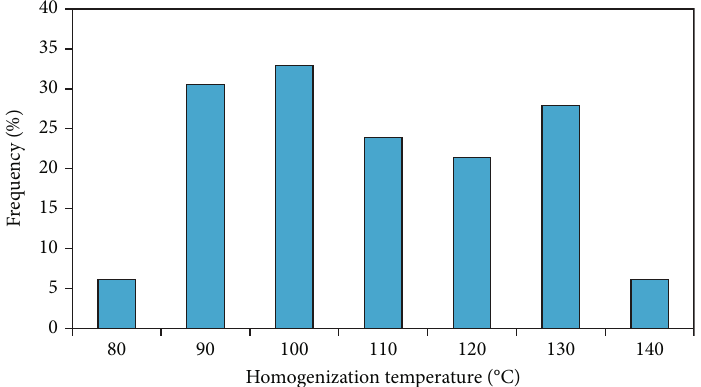
well: (a) terpane; (b) sterane. 46